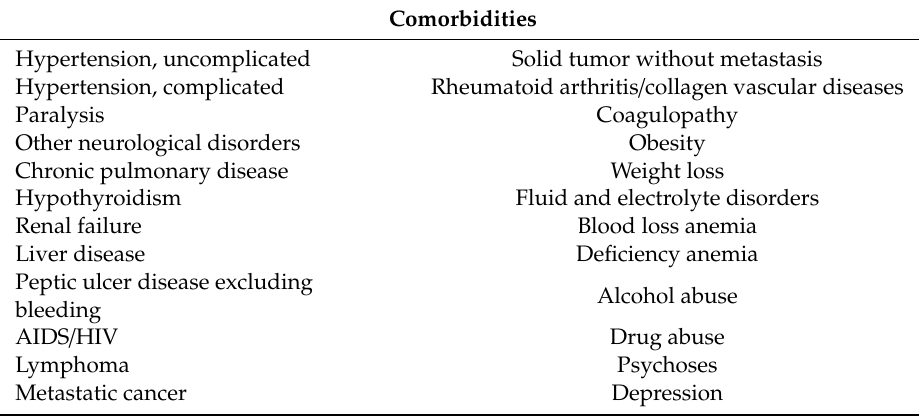
Table 4. Elixhauser comorbidity list used in this proposed